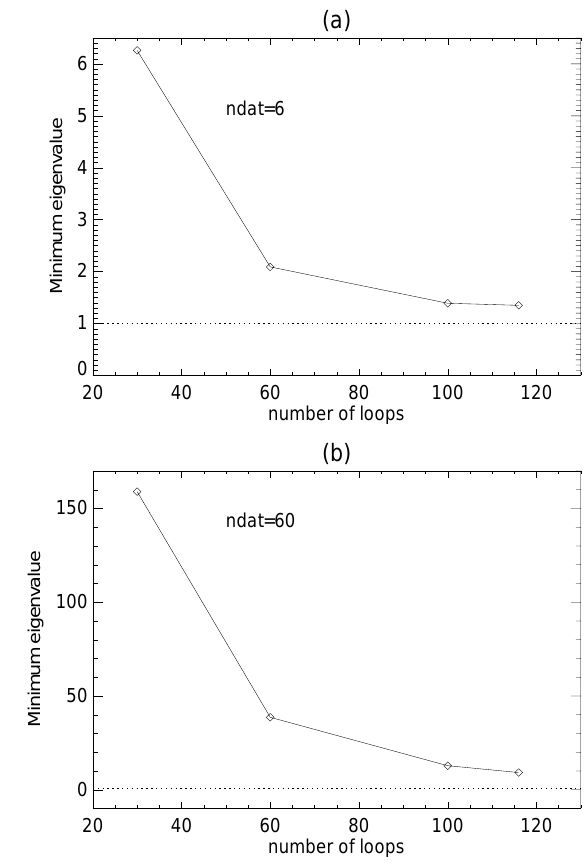
Fig. 2. The smallest eigenvalues as a function of the number of loops (a) for ndat = 6 and (b) for ndat = 60. inner loops. The maximum eigenvalues are very similar in all cases with different values of K , as shown in Fig. 1e–h. As an example of eigenvector structure, we plotted in Figs. 3 and 4 the top five normalized eigenvectors ( Q n for temperature t and zonal wind component u for K = 30 , 60 , 100 , and 116 at 500 hPa. The number of data sets is ndat = 6. From left to right, Fig. 3 shows the largest eigen- vectors of t with different values of K , while the top 5 eigen- vectors of t with the same value of K are shown from the top to the bottom, respectively. On the top panel, the 1st eigen- vector for t has a similar dipole structure over North America for K = 30 and 60, while for K = 100 and 116, their struc- tures are also similar, but different from when K = 30 or 60. This is also true for the other dominant eigenvectors 2 , 3 , 4 , and 5 shown in the following rows. When K = 30,